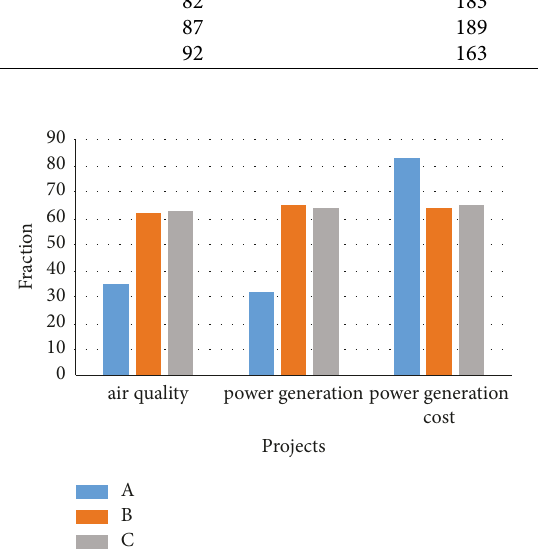
Figure 5: Comparison of air quality, power generation, and power generation costs in three